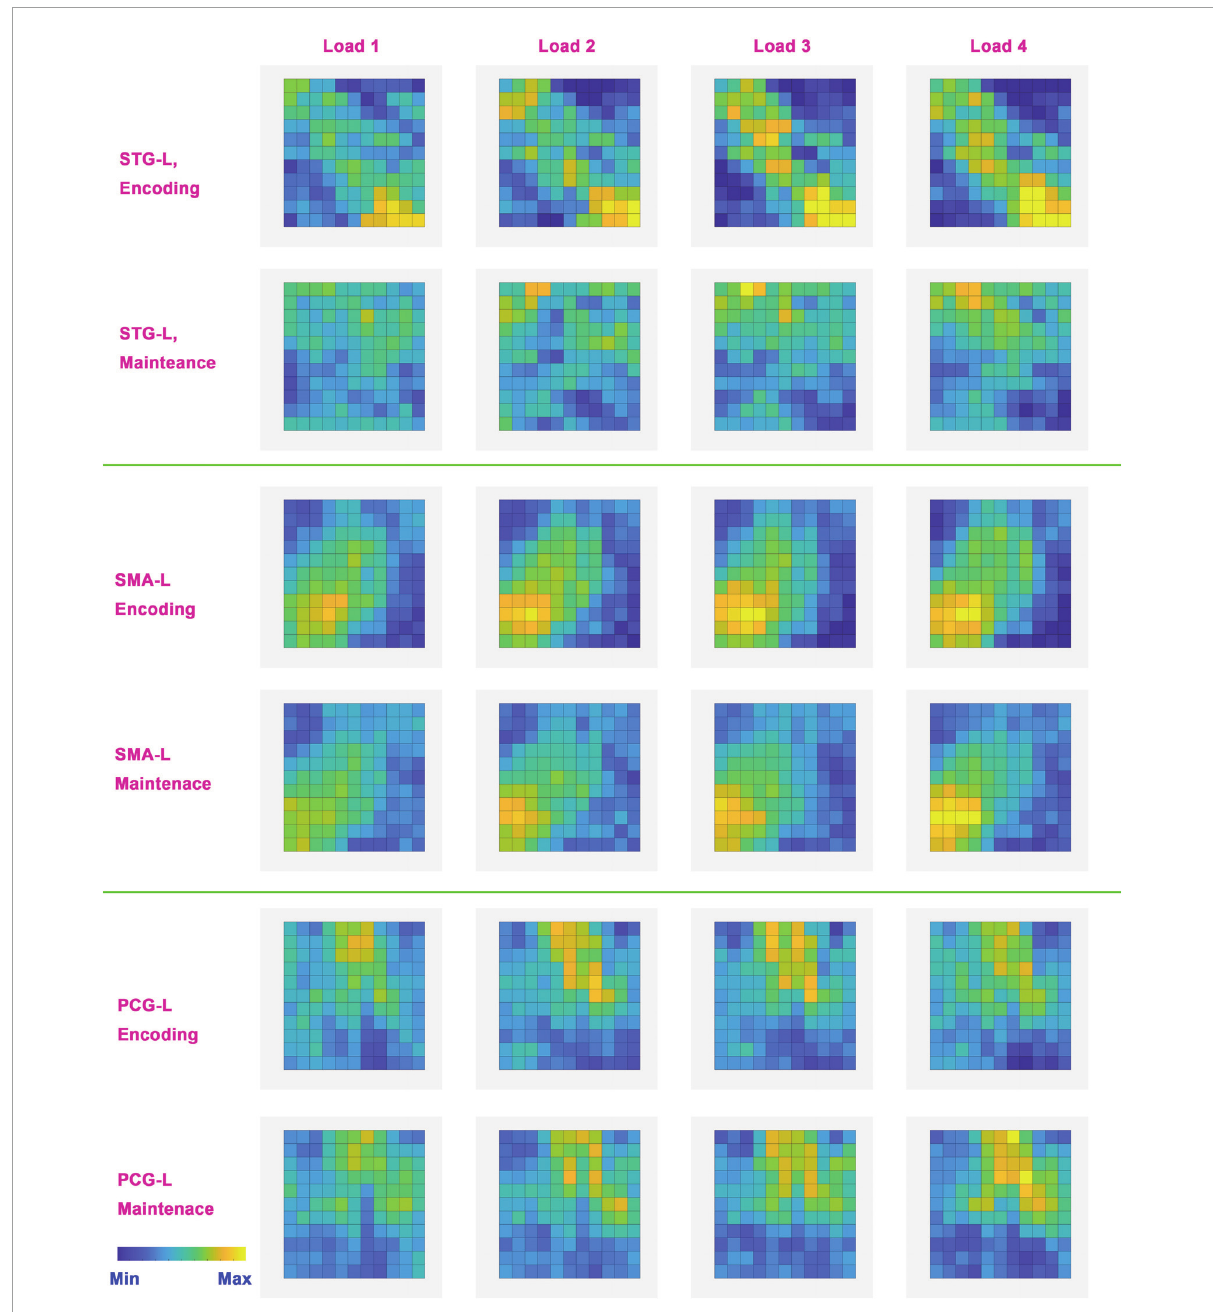
FIGURE7 Neural coding (local BOLD signal pattern) in the left STG, PCG, and SMA. These neural codes were obtained by subtracting the neural codes of the baseline condition from the neural codes of each load. Considering the 4 ∼ 6 s delay of BOLD signal, the neural codes of the encoding phase were acquired from the 6th second and the neural codes of the maintenance phase were acquired from the 12th second. Bright colors indicate a strong BOLD signal and dark colors indicate a weak BOLD signal.